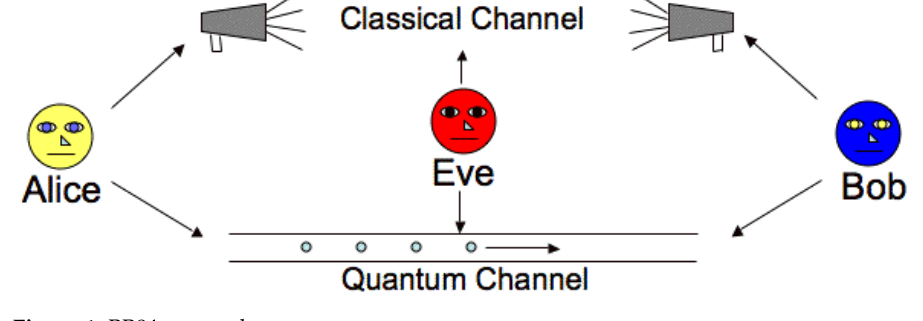
Figure 1. BB84 Figure 1. BB84 protocol. Table 4. The four possible states of a qubit in a BB84-encoded string.